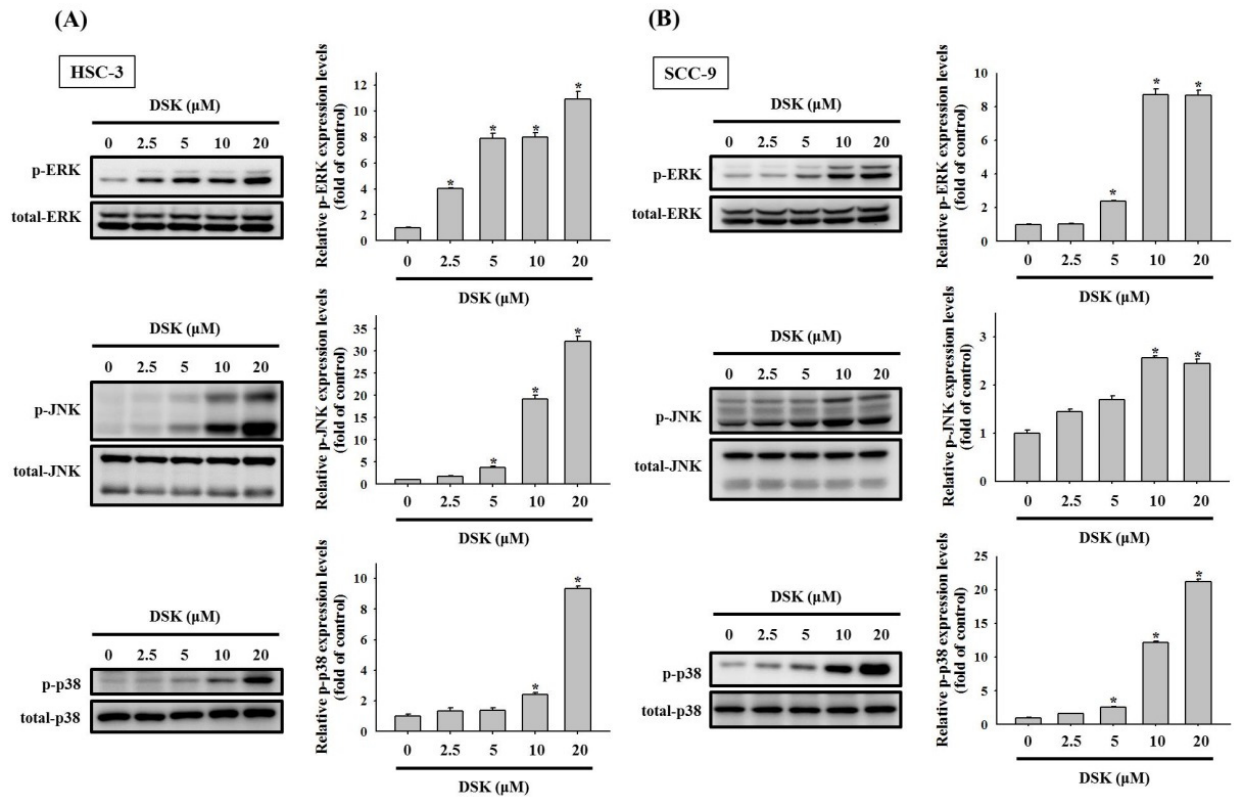
Figure 6. Phosphorylation of three MAPK pathway in DSK-treated HSC-3 and SCC-9 cells. HSC-3 ( A ) and SCC-9 ( B ) cells were treated with indicated concentrations of DSK for 6 h and assessed for the phosphorylation status of ERK1/2 (ERK), JNK, and p38-MAPK by immunoblotting with indicated antibodies. Densitometric analyses were quantified and normalized with total protein. The values represent the mean ± SD of three independent experiments. * p < 0.05 compared with untreated controls using Student’s t -test.